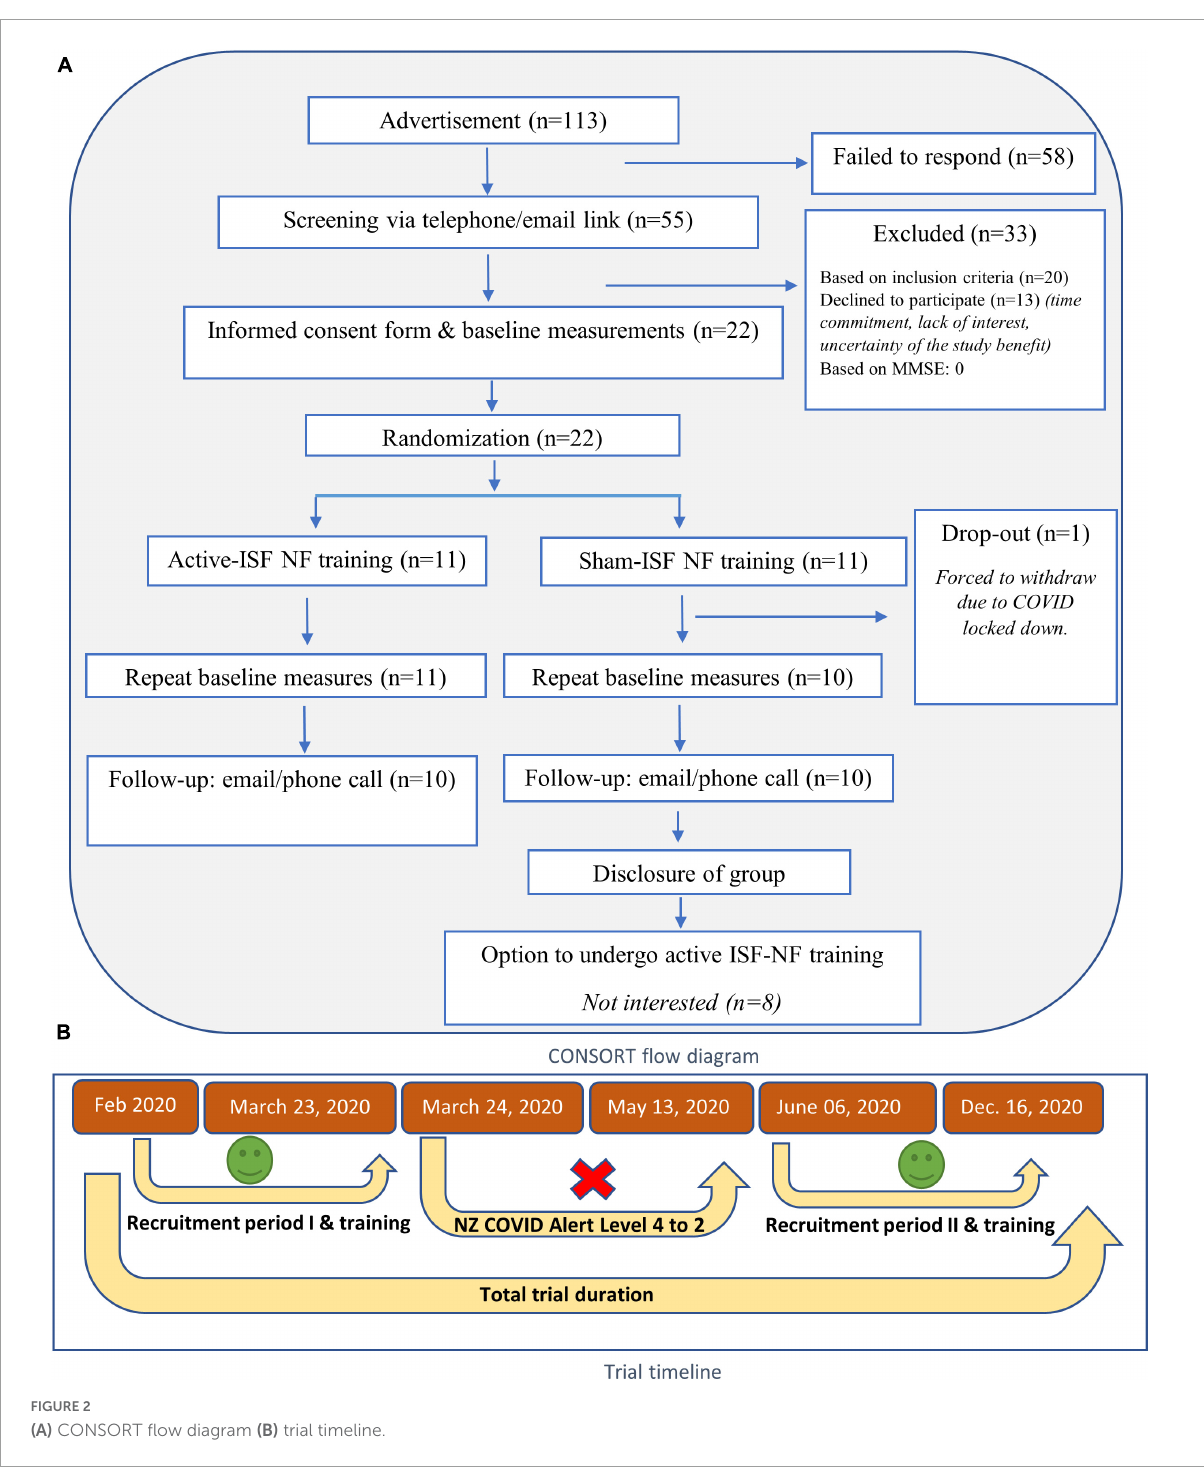
FIGURE2 (A) CONSORT flow diagram (B) trial